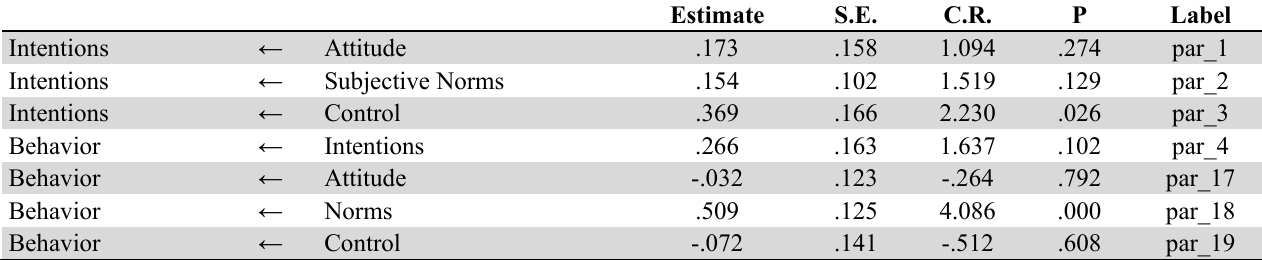
Hypothesis Test